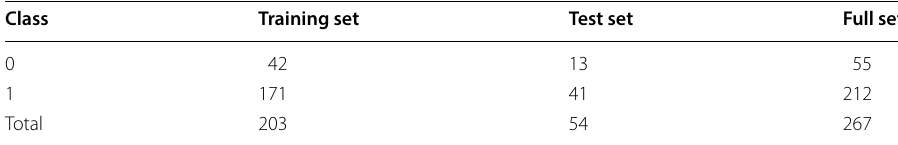
Table 10 Composition of SPECT data for example